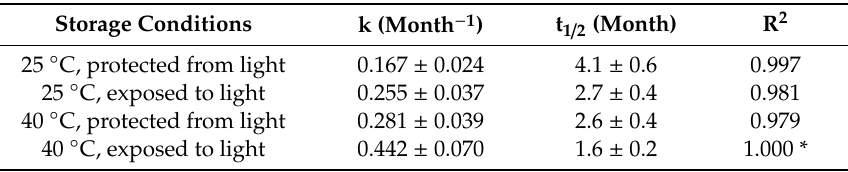
Table 3. Kinetic parameters for the unknown anthocyanin degradation in grape stem extracts stored under di ff erent